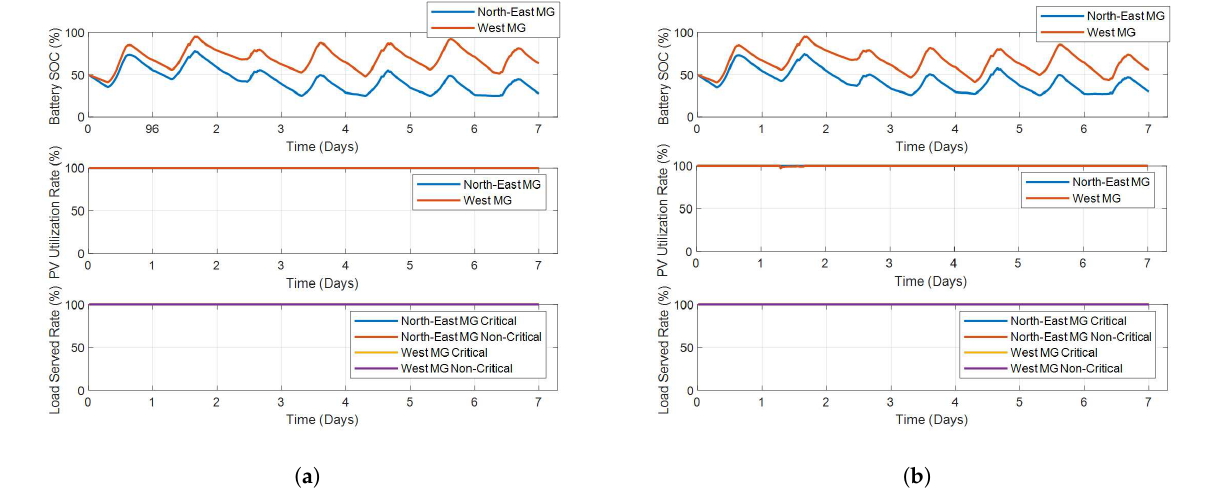
Figure 14. Optimization results of Adjuntas 2-microgrid system in Case 2. ( a ) Centralized Method. ( b ) Distributed